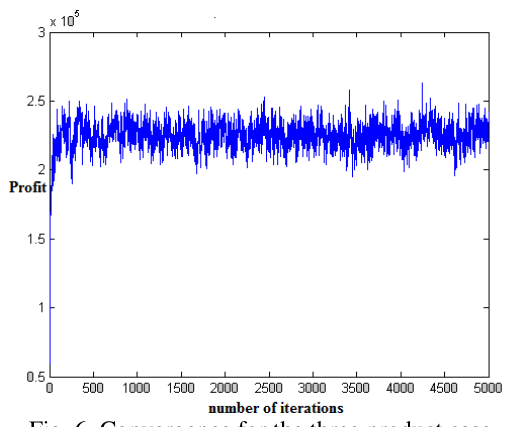
Fig. 6. Convergence for the three product case